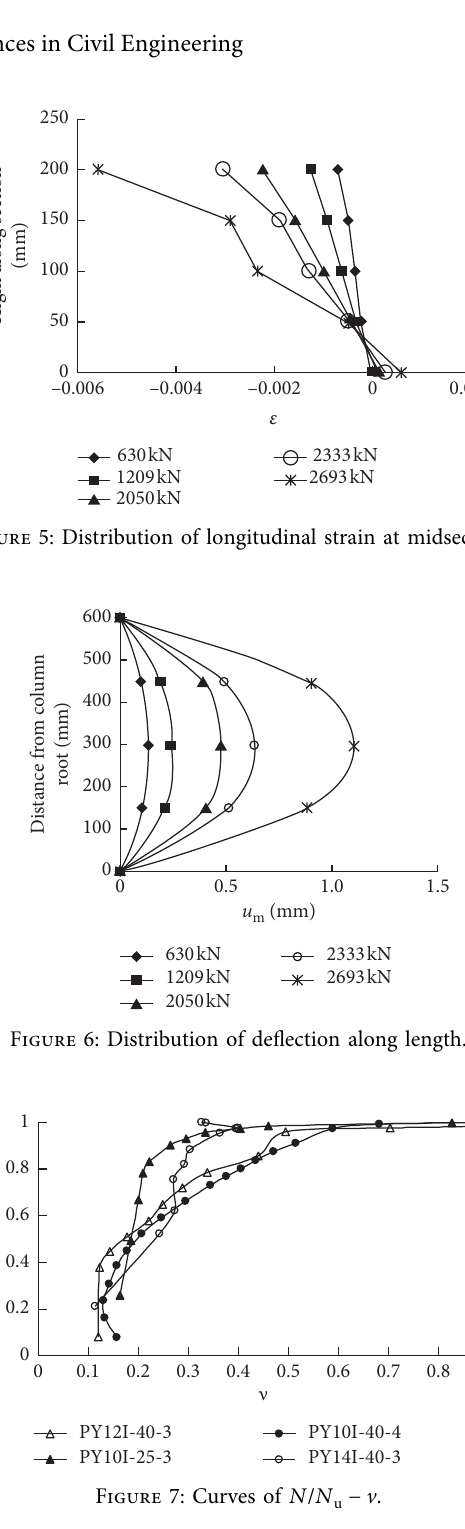
Figure 7: Curves of N / N